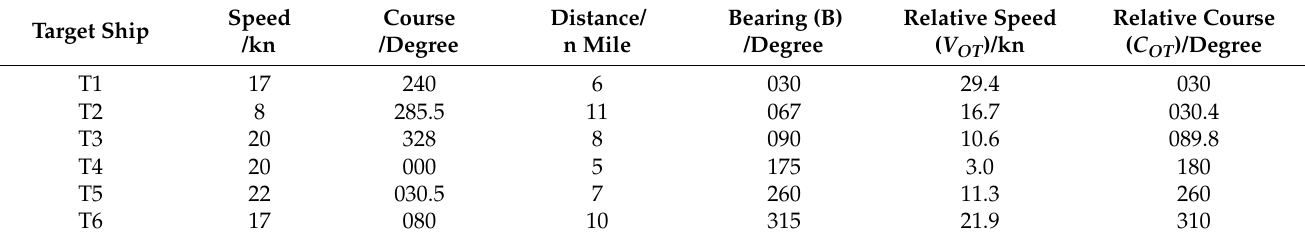
Table 2. Motion data of target ship.